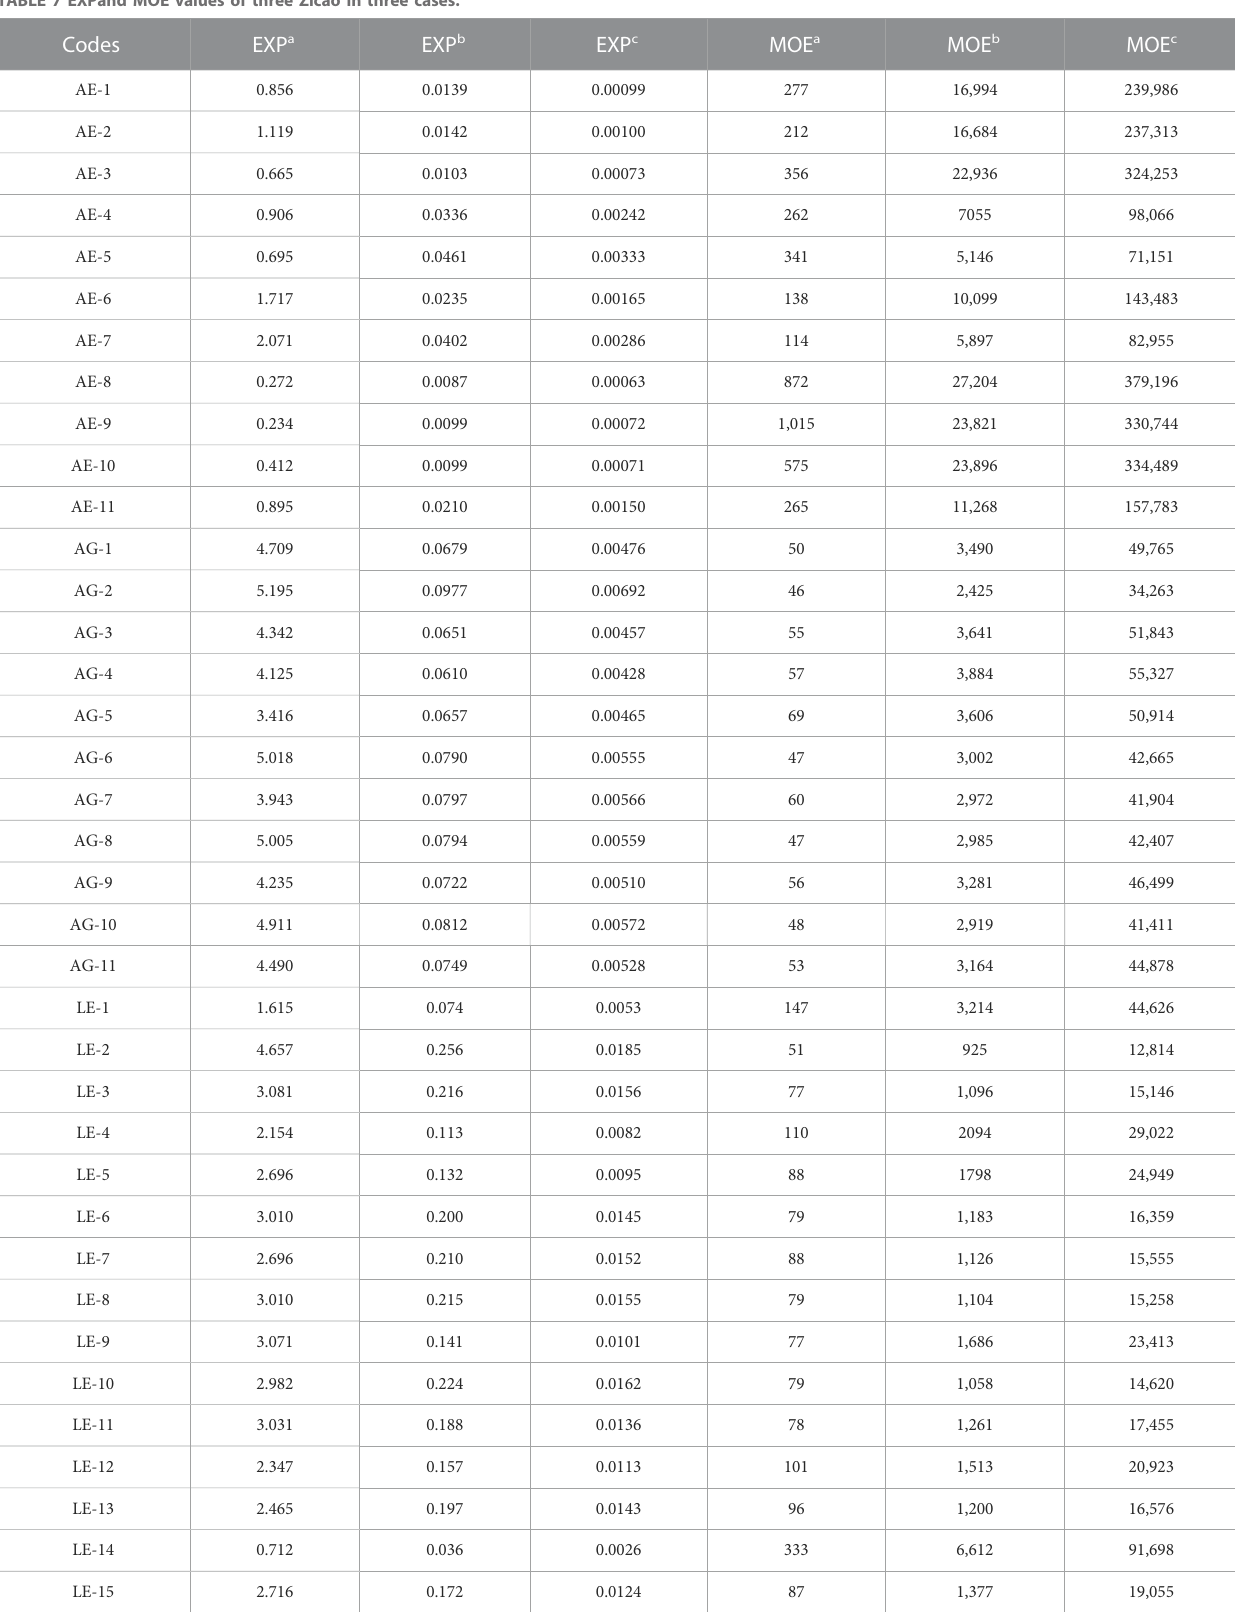
TABLE 7 EXPand MOE values of three Zicao in three